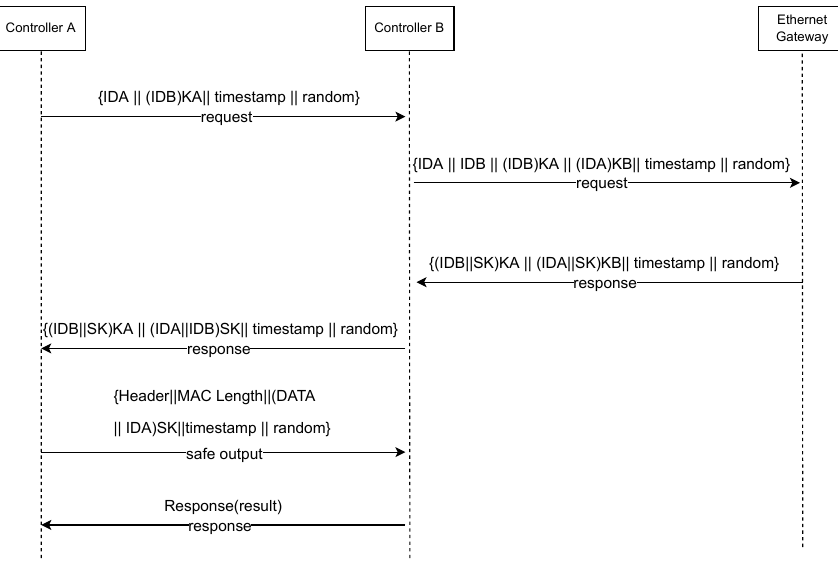
Figure 9. Message flow with improved